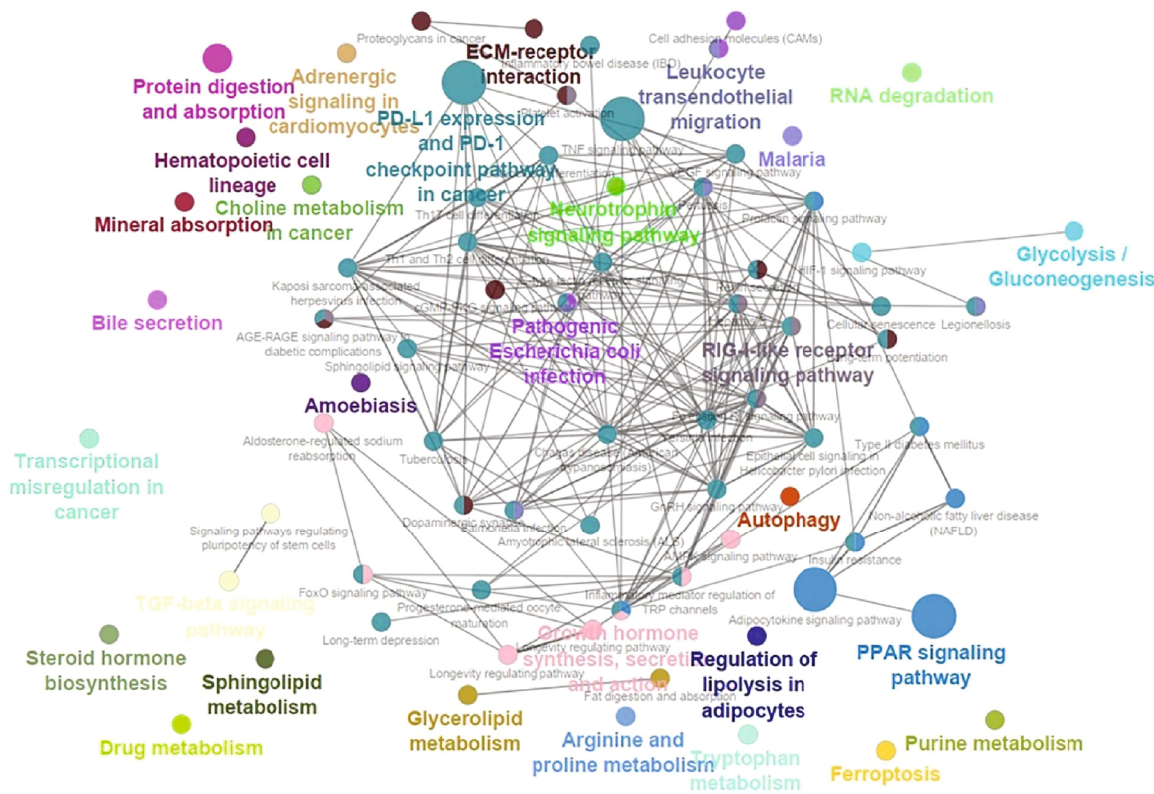
Figure 3: ClueGO results of interconnection between pathways in the network of human MAFLD DEGs. Hub pathways are shown as bigger nodes.